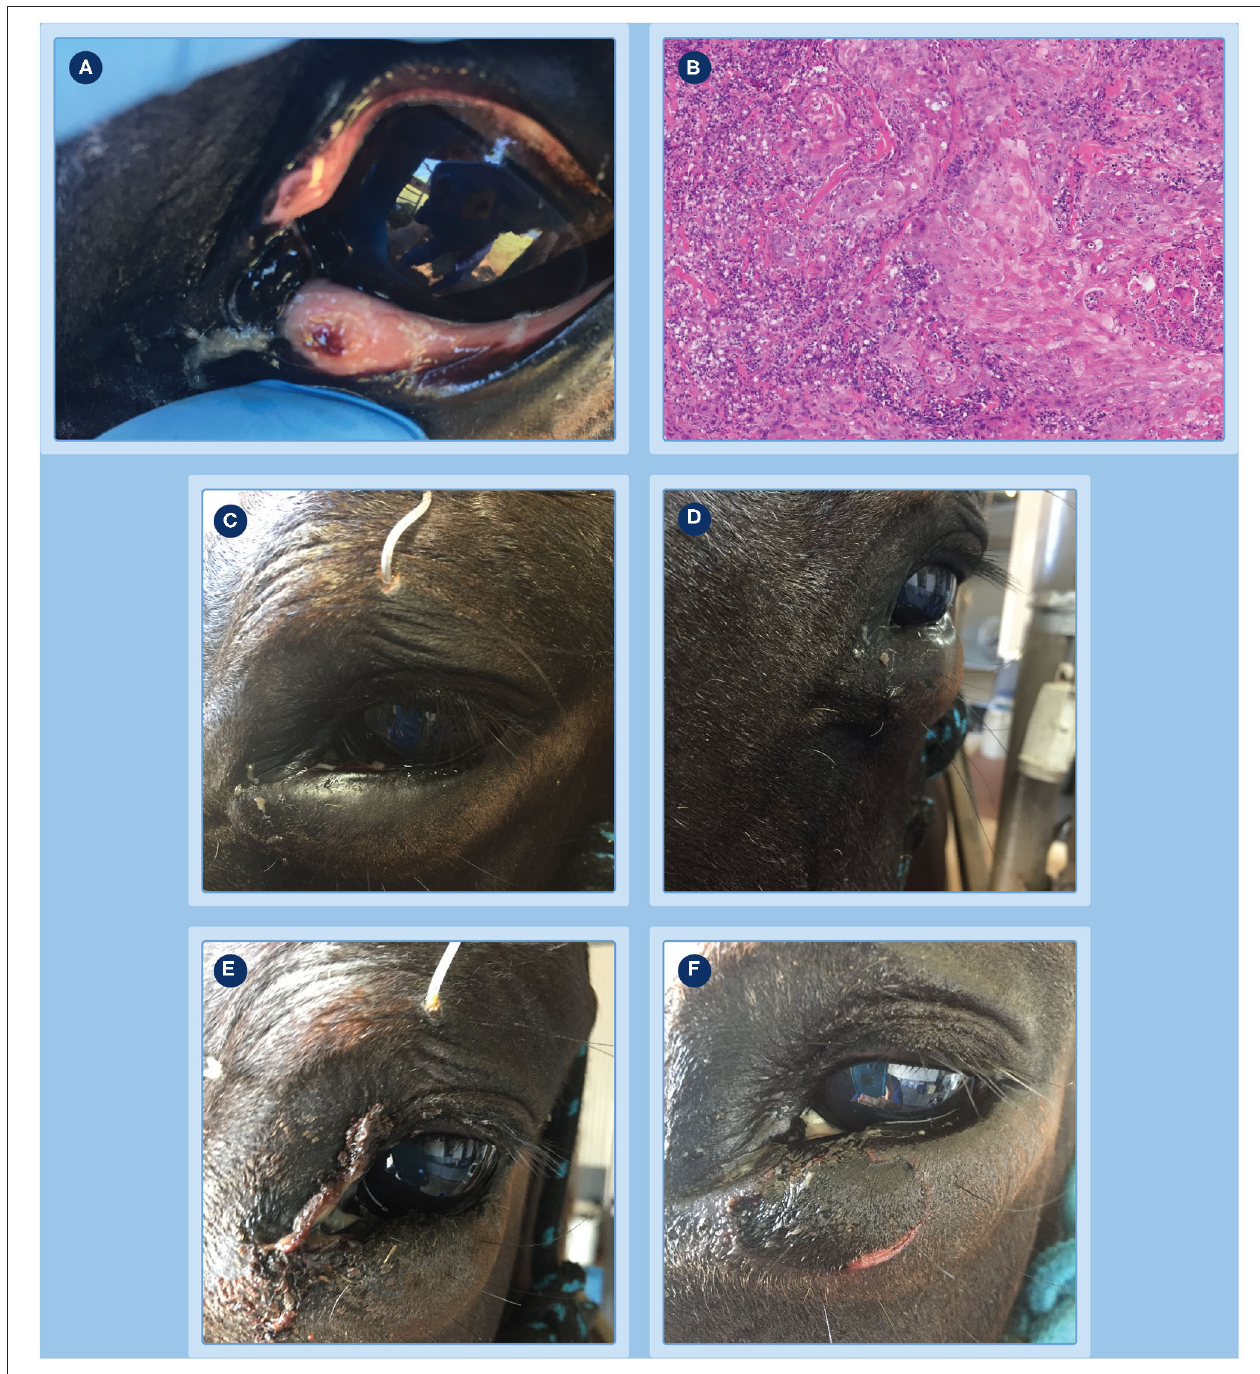
FIGURE 2 | Progression of clinical response of a peri-ocular SCC to treatment with tigilanol tiglate. (A) the tumor pre-treatment; (B) histopathology confirming the diagnosis as an SCC; (C,D) the extent of local swelling and inflammation that had developed by 24h; (E) haemorrhagic necrosis of the tumor and associated discharge of exudate at day 3; (F) markedly circumscribed and blackened area at the treatment site with eschar formation becoming visible at day 4.